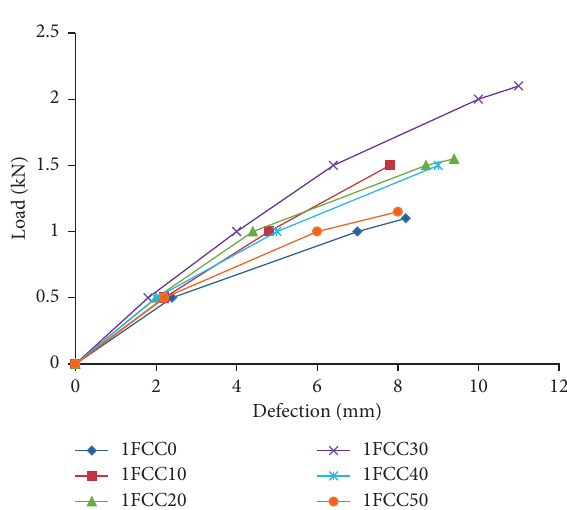
Figure 5: Load vs. deflection for ferrocement laminates with volume fraction 0.94%.